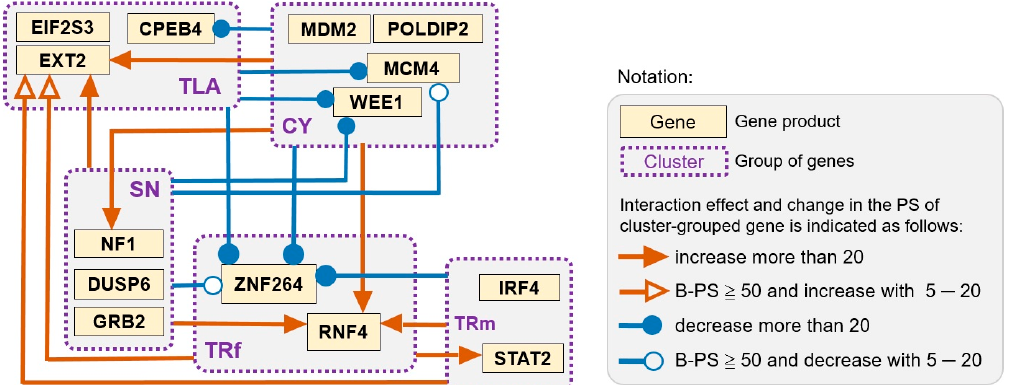
Figure 2. Schematic presentation of valid cluster–gene interactions identified by two-cluster analysis. String derived from the edges of a cluster indicates the existence of cluster-derived influence on the pointed gene grouped in another cluster. The magnitude of the change in the percent of significance (PS) of the pointed gene from its basal PS (B-PS) is shown with an arrow (increase) or dot (decrease) next to the pointed gene. The LY cluster is not shown because of the absence of interaction with other clusters. Table 4. Cluster–gene interactions summarized from two-cluster analysis.